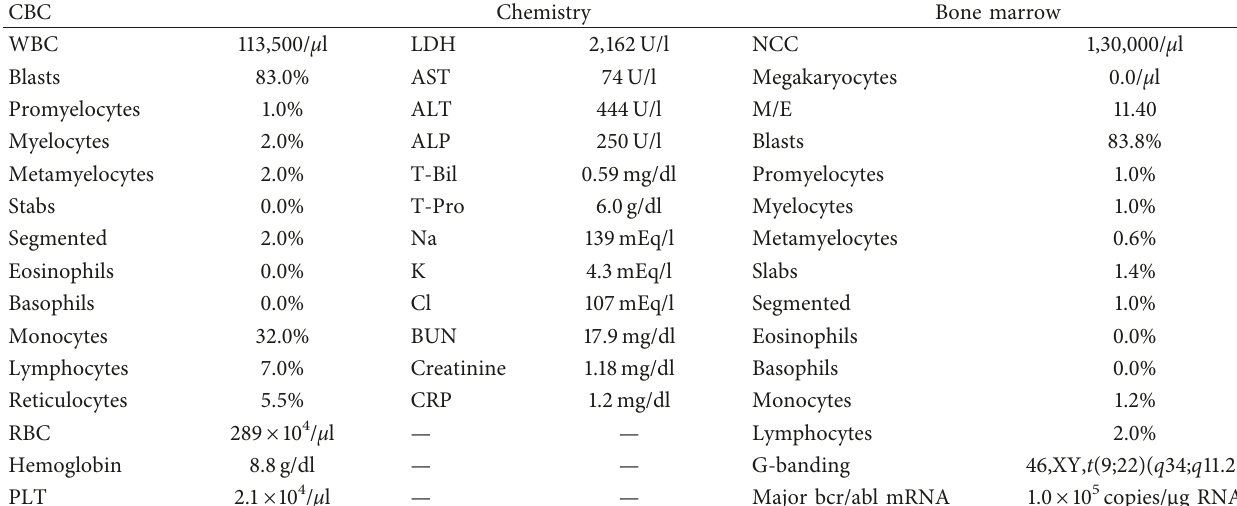
Table 1: Laboratory data on